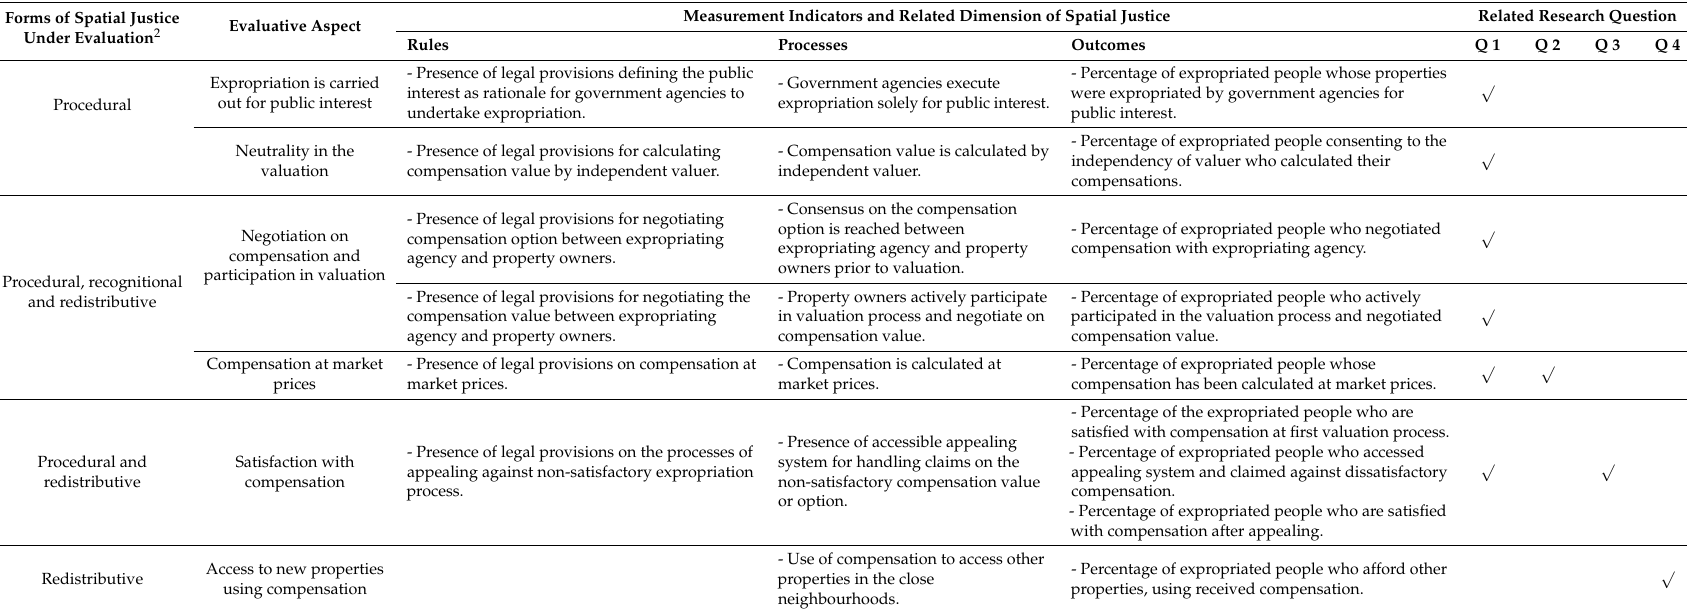
Table 1. Matrix for measuring spatial justice alongside the expropriation of the real property in Kigali